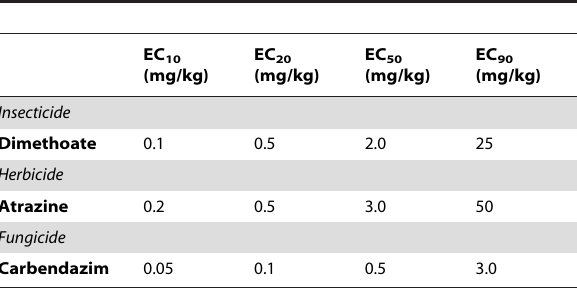
Table 1. Concentrations of dimethoate, atrazine and carbendazim used for exposures in Enchytraeus albidus